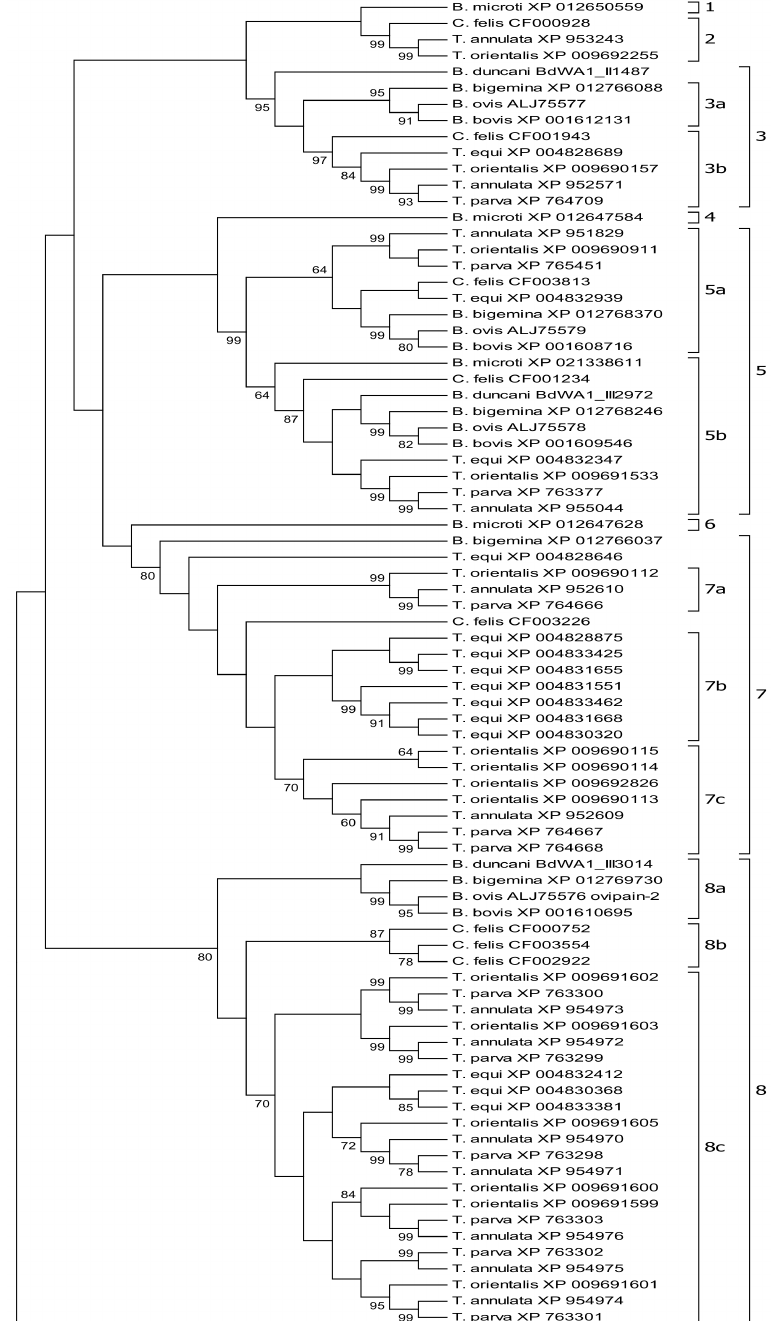
Figure 1. Maximum likelihood tree of C1A proteinase amino acid domains of Babesia , Theileria , and Cytauxzoon parasites. Each C1A cysteine proteinase sequence is designated with the corresponding piroplasmid species and accession number. Numbers 1–8 designate revealed C1A cysteine proteinase Groups 1–8. OG, outgroup. Bootstrap values based on 1000 replicates are displayed next to the